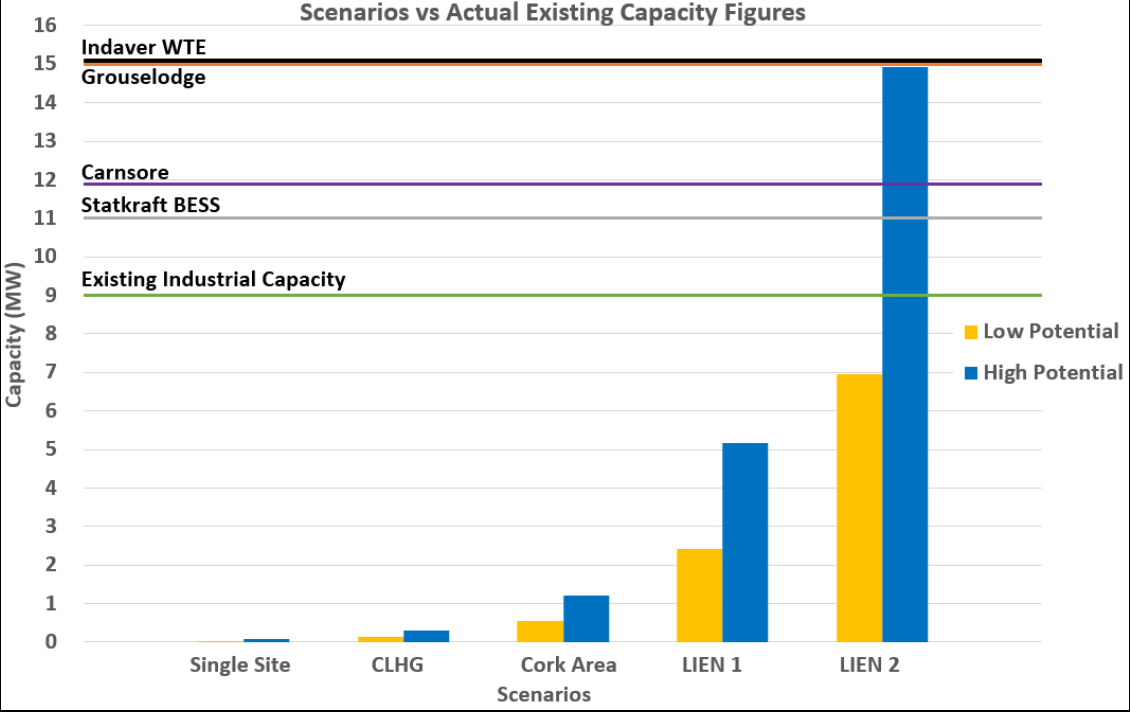
Figure 8. Bar chart illustrating the low (Yellow) and high (Blue) potentials achievable by each grouping scenario compared to actual existing capacity figures, illustrated by the horizontal annotated lines. Table 9. Overview of annual payments achievable by a single site offering low potential and high potential capacities under five of the frequency response DS3 system